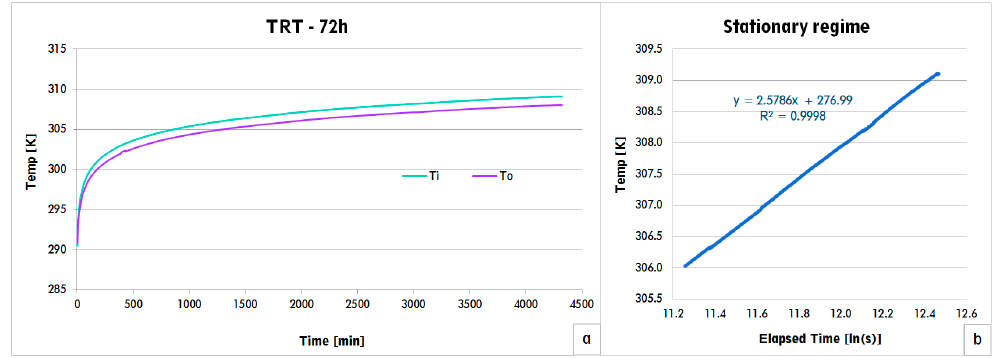
Figure 9. ( a ) TRT results for the time lapse of 72 h, ( b ) stationary regime considering 2825 sampling values. Table 3. Calculation of the e ff ective thermal conductivities for each time interval.